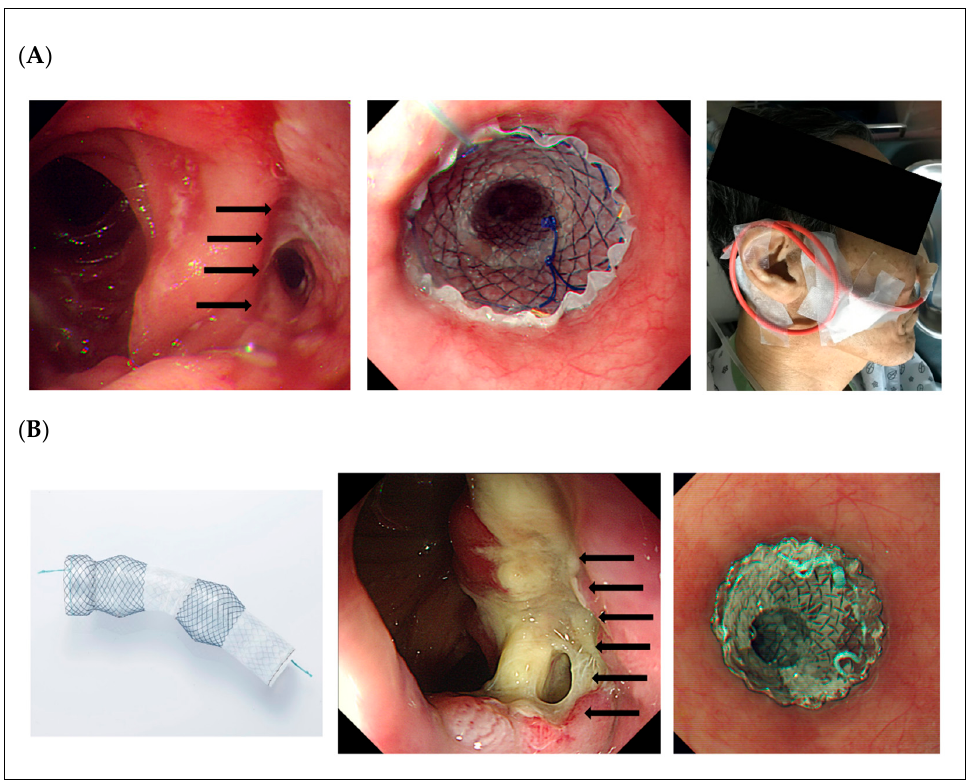
Figure 1. Stent placement for anastomotic leakage after gastrectomy. (A) Thread-fix stent place- ment is performed for anastomotic leakage after total gastrectomy and externally fixed through the nose using silk thread. (B) Niti-S Beta stent has a unique body structure with silicone-covered outer double layers, and the stent is placed for anastomotic leakage after total gastrectomy without external fixation.